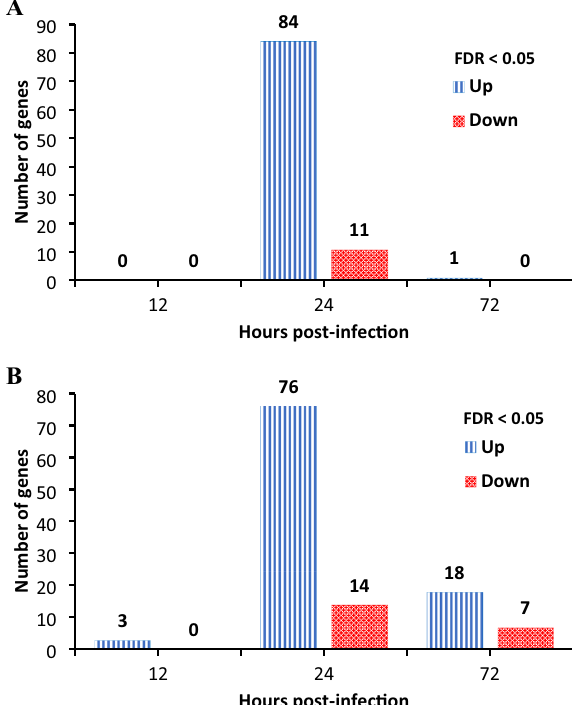
Figure 1. The number of significantly differentially expressed genes in the cecal tonsils and the ileum. Significantly differentially expressed genes in the cecal tonsils (panel A) and the ileum (panel B) following influenza virus infection (significant p-value of False Discovery Rate (FDR) controlled at 5%) over time. Blue bars indicate the number of upregulated genes, and the red bars indicate the number of downregulated